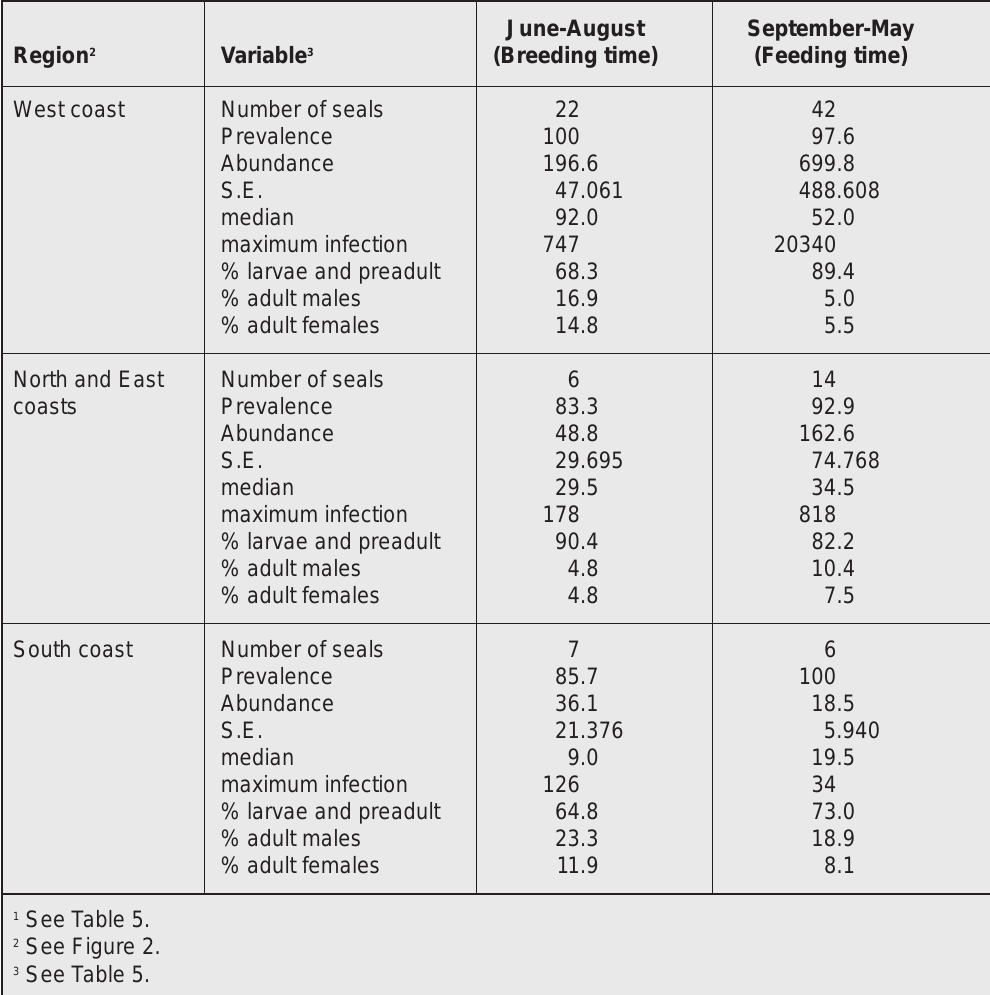
Table 6 . Characteristics of sealworm ( Pseudoterranova decipiens ) infections in stomachs of common seals ( Phoca vitulina ) older than four months in Icelandic waters in 1979-82. 1 (Ólafsdóttir and Hauksson